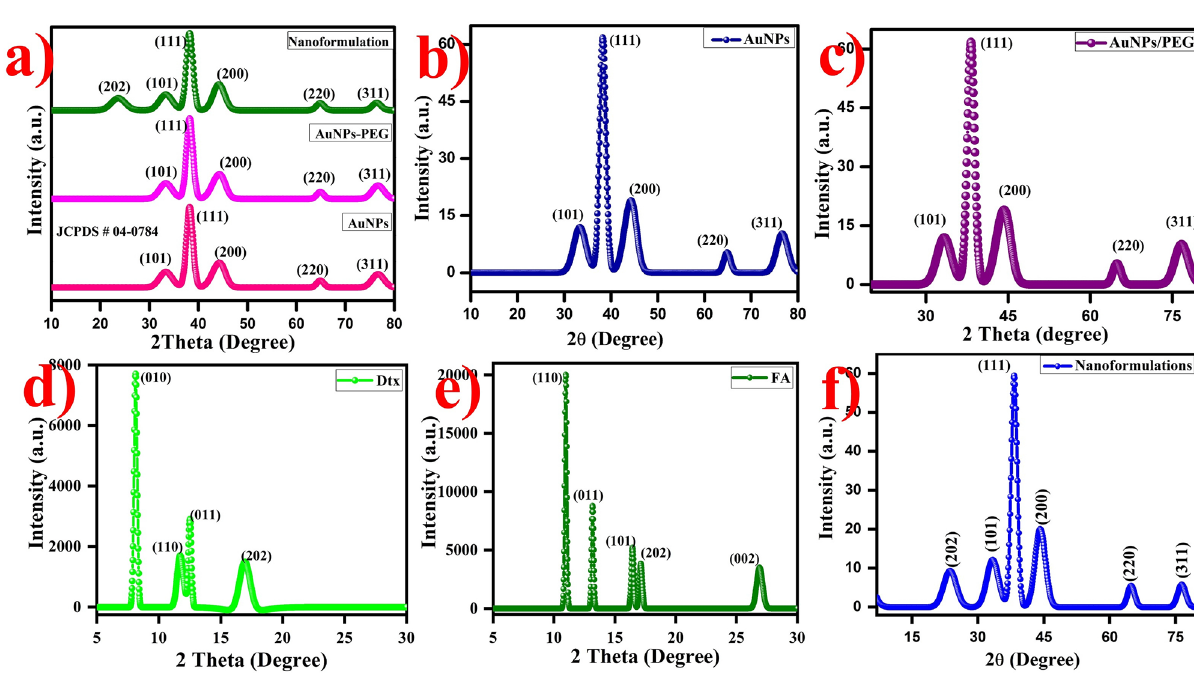
Figure 4. XRD pattern of the gold nanoformulations ( a ) Combined spectra of AuNPs nanoformulations, ( b ) AuNPs ( c ) AuNPs-PEG, ( d ) Dtx ( e ) FA and ( f ) gold nanoformulations were observed the FCC crystal